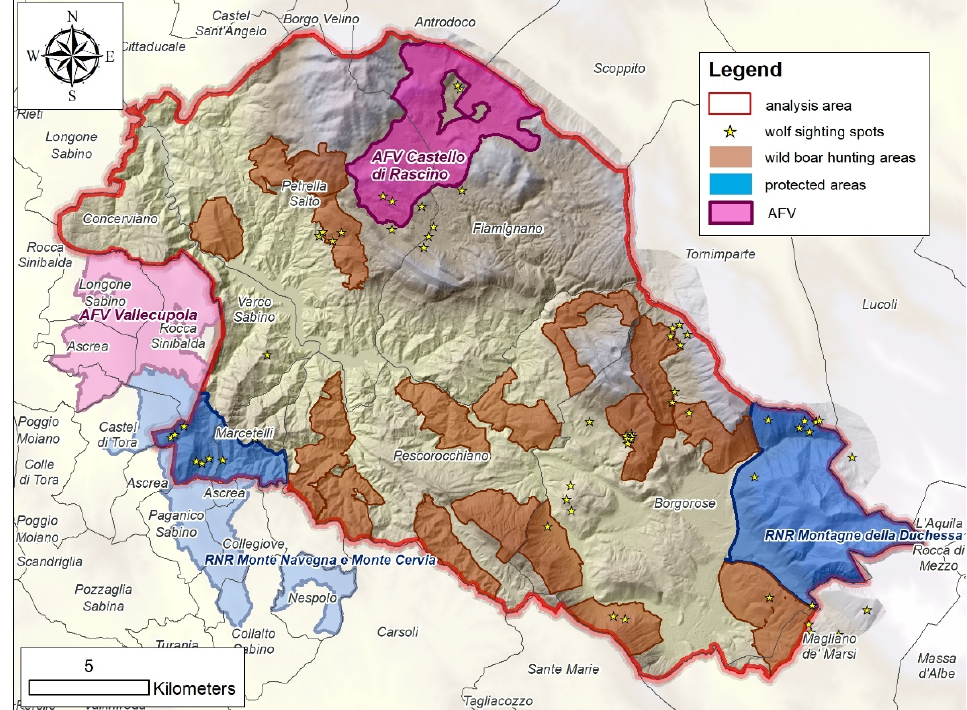
Figure 2. Maps of the territorial wildlife management plan. Brown polygons represent wild boar drive hunting areas. Blue polygons are the regional protected areas intersecting the study area. The private hunting areas (AFV) are identified in violet. Stars represent winter response sites (WRS).